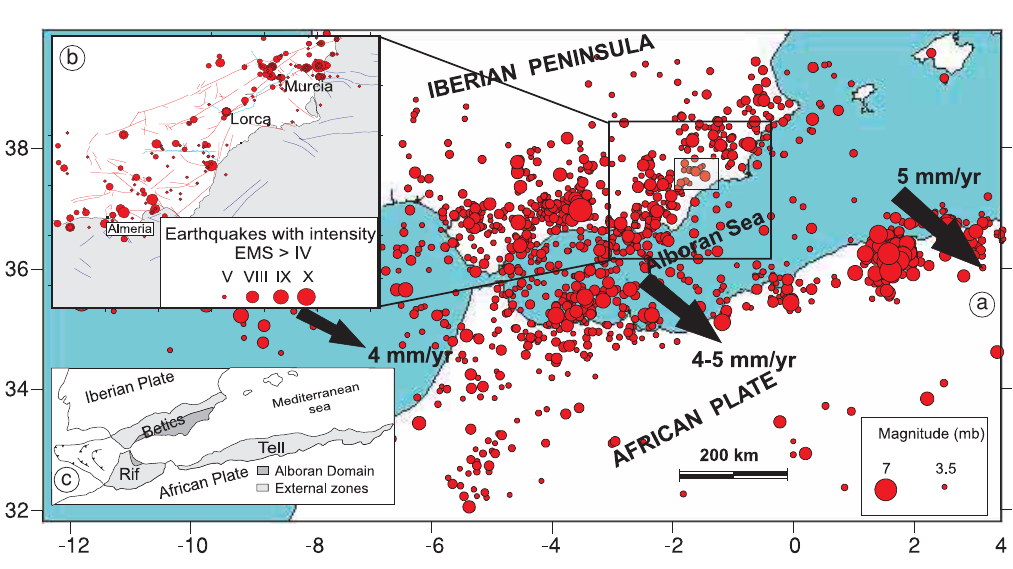
Fig. 1a-c. a) Map showing the location of the study area (square) and the instrumental seismic activity (period 1930-2001) related with the convergence of the Eurasian and African plates. The velocity vectors of plate convergence are taken from Argus et al. (1989). The increase in velocity from west to east is pro- duced by the increasing distance to the eulerian pole of the African plate. b) Seismic activity with intensi- ty > IV occurred in the Eastern Betic Cordillera from 500 A.D. to 2000, projected on a map of the Qua- ternary faults. Seismic data from the Instituto Geográfico Nacional. c) Regional map showing the regional frame of the study area with the situation of the internal zone (metarmorphic units of the Alboran Domain) of the Betic Cordillera, and the mesozoic and tertiary tectono-sedimentary units of the external zone of the